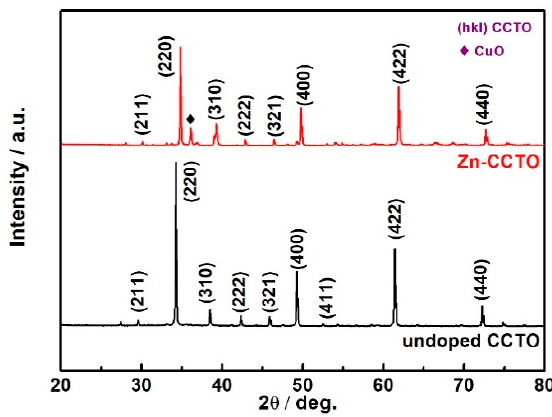
Figure 1. X-ray diffraction (XRD) patterns of undoped and Zn-doped calcium copper titanate (CCTO) prepared by rapid laser sintering of sol-gel derived precursors.